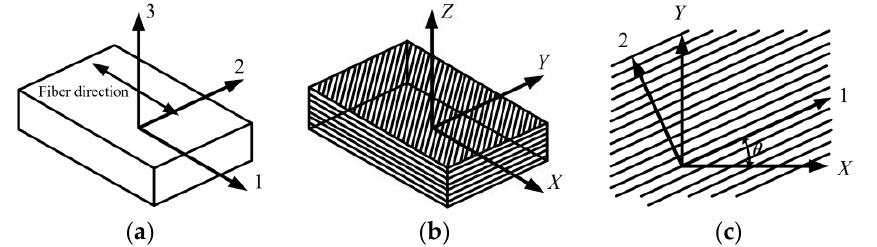
Figure 1. Material coordinate system of laminate: ( a ) Single-layer coordinate system; ( b ) Laminate coordinate system; ( c ) Positive rotation of